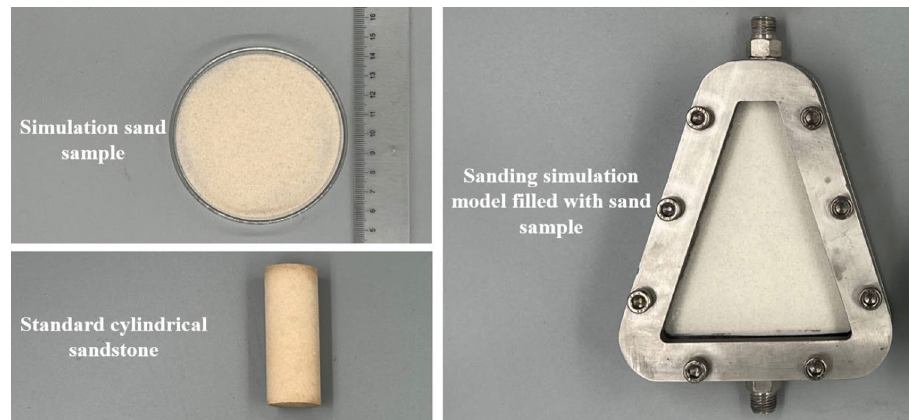
Fig. 4 View of simulation sand sample, standard cylindrical sandstone for UCS testing, and sand simulation model